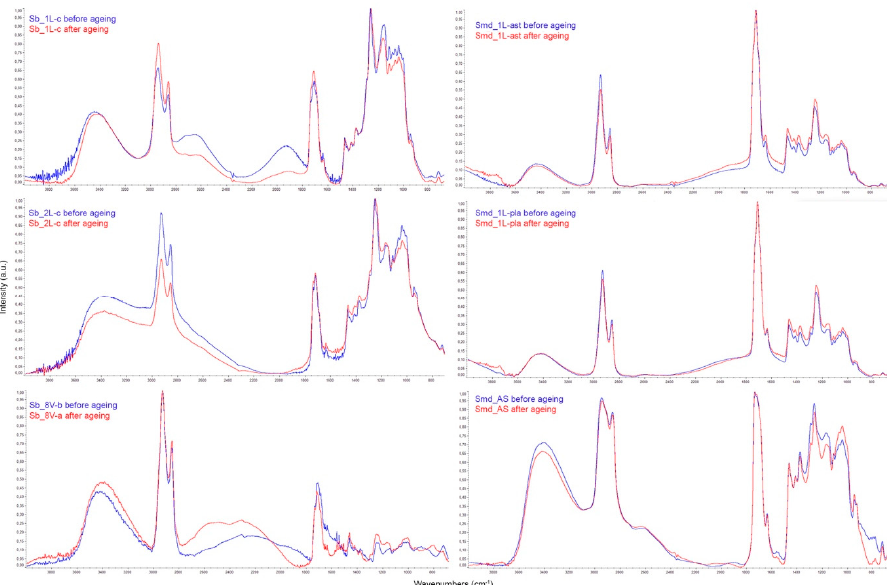
Figure 6. FTIR spectra of the samples before (blue spectra) and after (red spectra) ageing. On the left, from top to bottom: Sb_1L-c, Sb_2L-c, Sb_8V-b (and Sb_8V-a); on the right, from top to bottom: Smd_1L-ast, Smd_1L-pla, Smd_AS.